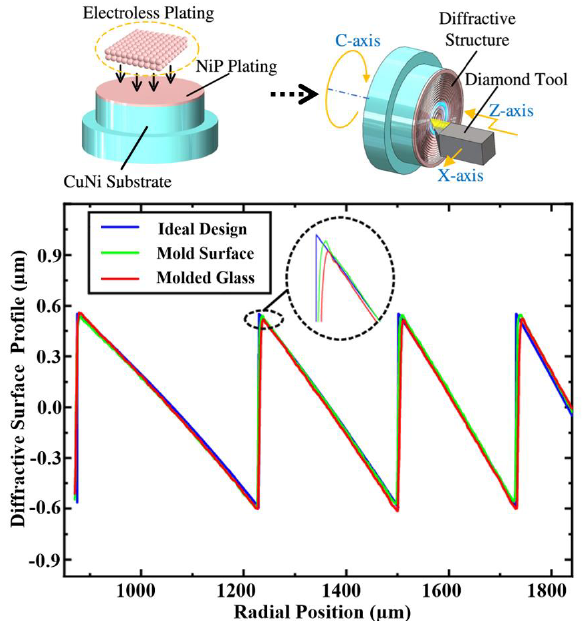
Fig. 4. (top) Schematic diamond turning process of the MODE lens’ diffractive Fresnel surface mold. (bottom) Diffractive Fresnel surface profile comparison between the design, the diamond turned mold, and the molded glass surface.